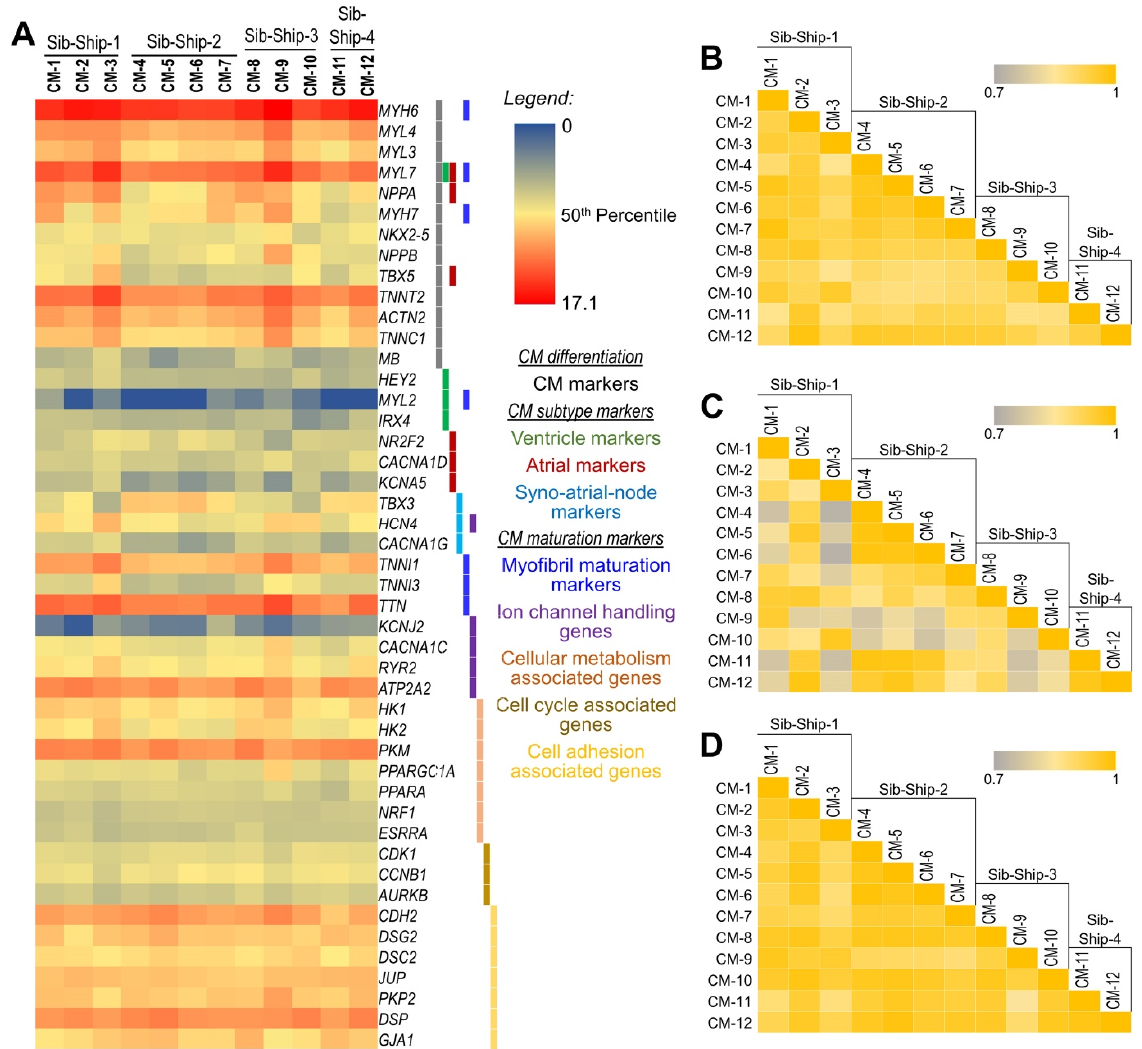
Figure 2. Expression analysis of CM-specific, CM-subtype-specific, and CM maturity-associated genes to assess uniform CM population across 12 CM samples. ( A ) Heat map showing normalized (log 2 ) expression of CM-specific, CM-subtype-specific, and CM maturity-associated genes in 12 iPSC-generated CM lines. ( B – D ) Correlation coefficient (r 2 ) plots based on ( B ) CM-specific, ( C ) CM-subtype-specific, and ( D ) CM maturity-associated genes in 12 iPSC-generated CM lines, respectively.